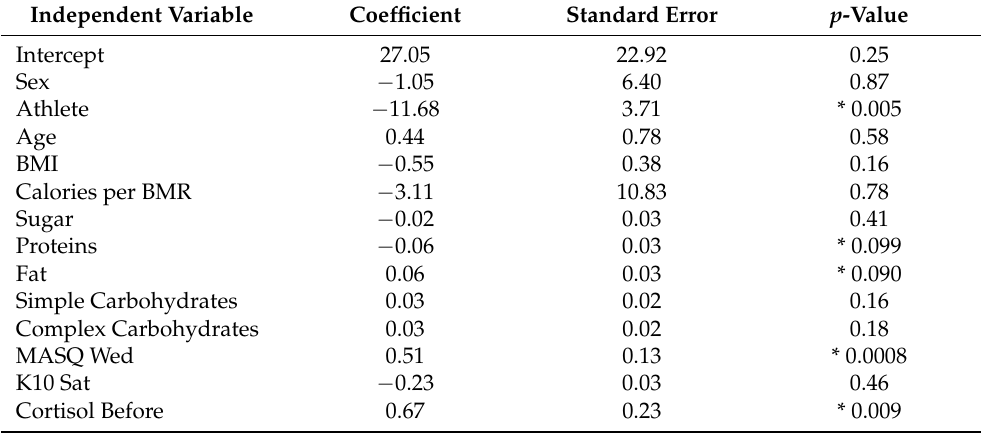
Table 12. Regression results of MASQ Saturday score (dependent variable) and sex, age, BMI, athlete, calories per BMR, cortisol levels before exercise, K10 scores on Saturday, MASQ scores on Wednesday, sugar, proteins, fat, simple carbohydrates, and complex carbohydrates (independent variables). * p <